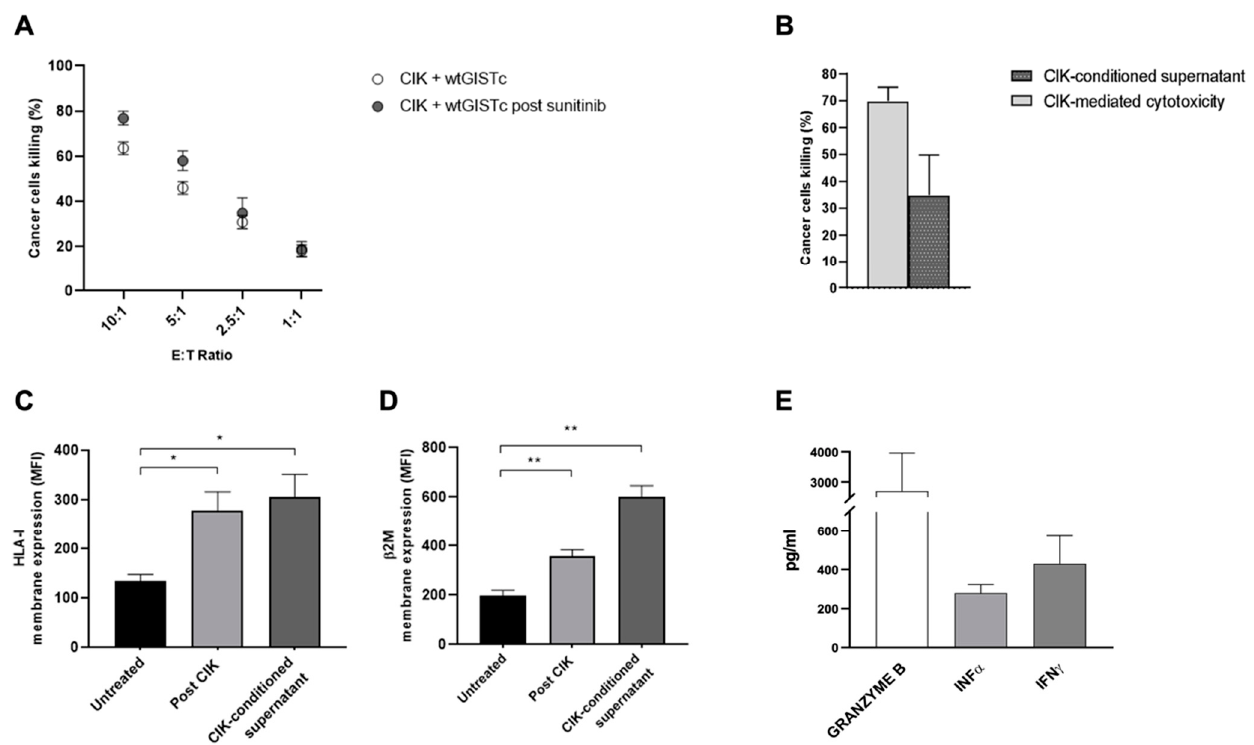
Figure 5. ( A ) Antitumor activity of CIK against wtGISTc resistant to TKI. Patient-derived CIK efficiently killed in vitro wtGISTc resistant to imatinib. The CIK killing ability was retained when sequentially tested against wtGISTc that survived treatment with sunitinib. ( B ) CIK-conditioned medium is endowed with tumoricidal activity against wtGISTc in vitro. CIK-conditioned supernatants, collected after 72 h co-culture of CIK with wtGISTc, was shown to be capable of cancer cell killing activity even in the absence of a direct CIK-tumor contact. ( C , D ) Direct and indirect modulation of HLA-I and β 2M in wtGISTc by CIK lymphocytes. The membrane expression of both HLA-I ( C ) and β 2M ( D ) on wtGIST was enhanced after treatment with CIK or CIK-conditioned medium (* p < 0.05; ** p < 0.005, nonparametric t -test). ( E ) Soluble factors produced by activated CIK lymphocytes. Granzyme B, IFN α and IFN γ are intensely produced by CIK following contact with wtGIST (10:1 E:T).